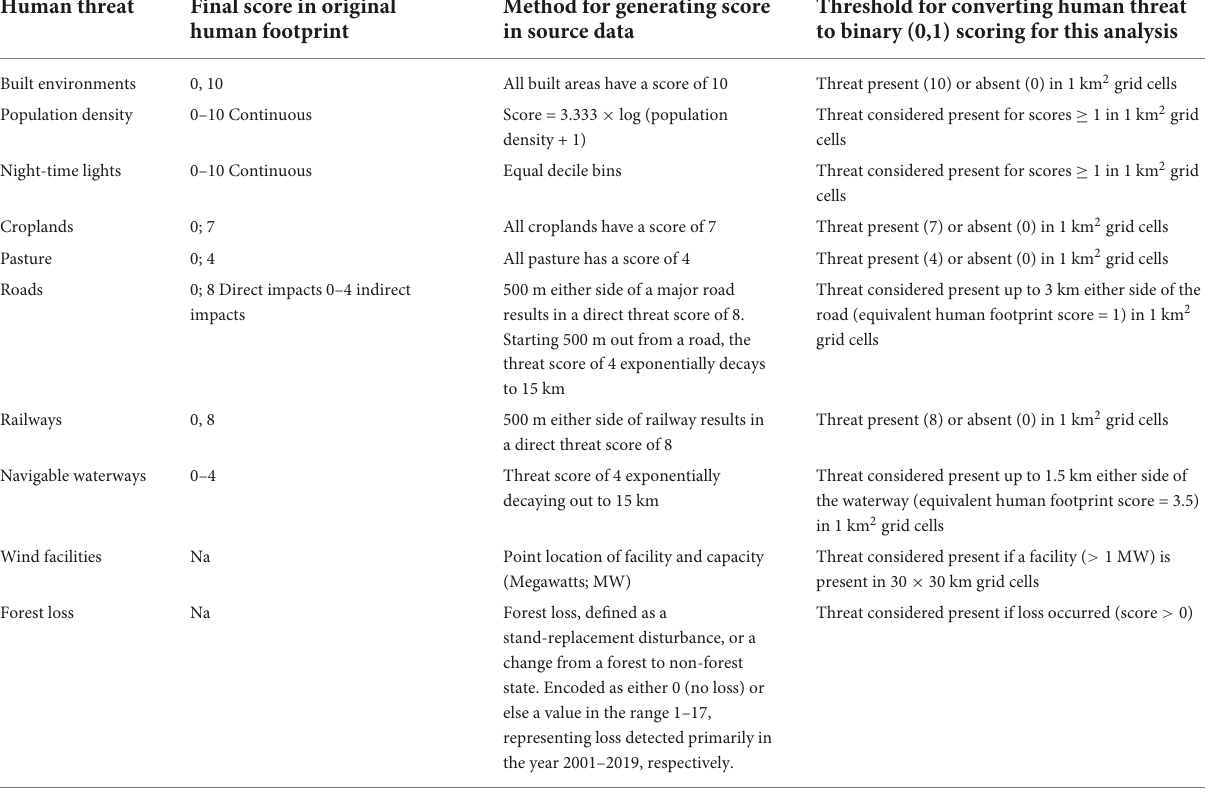
TABLE 1 Scores assigned to individual threats in the Human Footprint, GlobalData, and Global Forest Change (Hansen et al., 2013; Venter et al., 2016a; GlobalData, 2018), the method by which the human footprint scores were originally designated, and the threshold scheme used to convert the scores into binary (1 = present or 0 = absent) for our impact analyses following (Allan et al.,